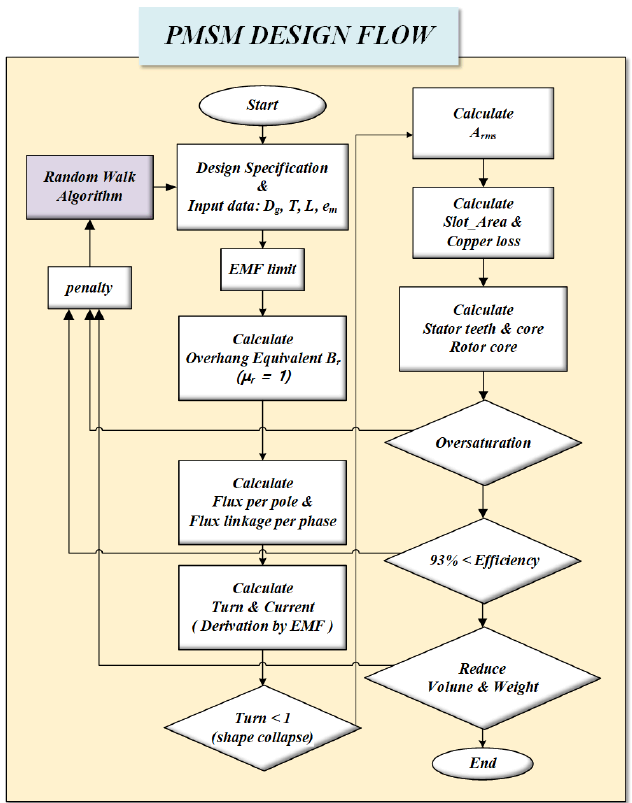
Figure 6. Design flow chart of PMSM applying random walk algorithm and semi 3D MEC.